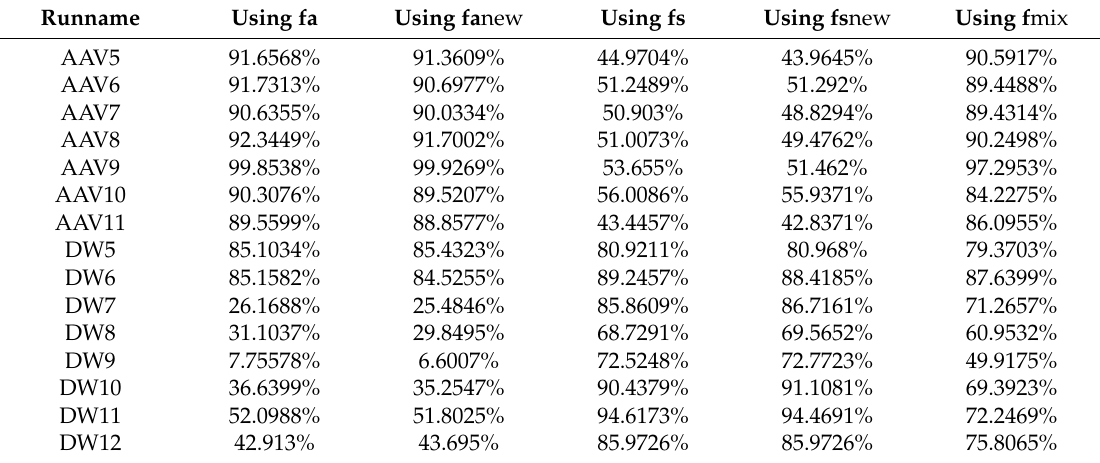
Table 5. Comparison of classification accuracy using different feature vectors.